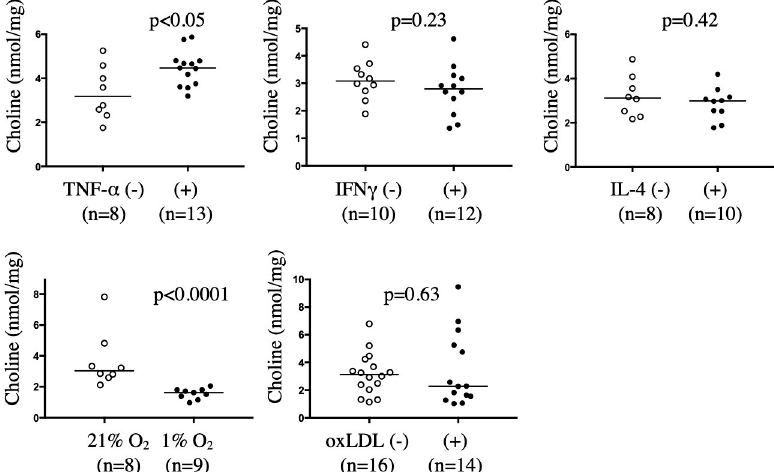
Fig 6. Effect of TNF- α , INF γ , IL-4, hypoxia, and oxidized low-density lipoprotein (oxLDL) on choline levels in peripheral blood mononuclear cell (PBMC)-derived macrophages. Choline levels in cultured macrophages were measured 3 days post-stimulation with TNF- α (10 ng/mL), IFN γ (50 ng/mL), and IL-4 (20 ng/mL), 1 day after exposure to hypoxia, or 2 days after administration of oxLDL (50 μ g/mL). Choline levels in non-stimulated macrophages (3.4 ± 1.1 nmol/mg) or TNF- α -stimulated macrophages (4.4 ± 0.8 nmol/mg). Choline levels in non- stimulated macrophages (3.1 ± 0.7 nmol/mg) or IFN γ -stimulated macrophages (2.7 ± 0.9 nmol/mg). Choline levels in non-stimulated macrophages (3.2 ± 0.9 nmol/mg) or IL-4-stimulated macrophages (2.9 ± 0.7 nmol/mg). Choline levels in normoxic macrophages (21% O 2 , 3.7 ± 1.7 nmol/mg) or hypoxic macrophages (1% O 2 , 1.6 ± 0.3 nmol/mg). Choline levels in non-stimulated macrophages (3.2 ± 1.5 nmol/mg) or oxLDL-stimulated macrophages (3.4 ± 2.6 nmol/mg). Data are represented as mean ± standard deviation, and individual data points and median for each group. Data were analyzed using Mann-Whitney U